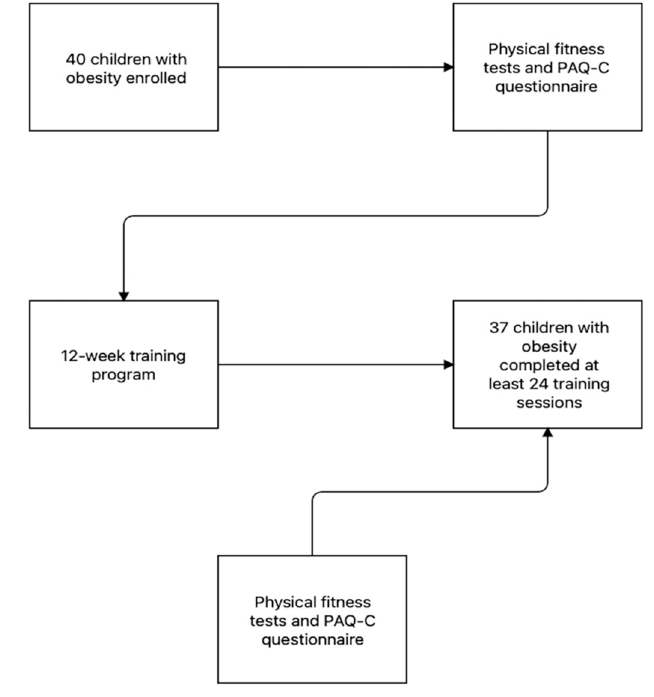
Figure 1. Flow chart of the study protocol.